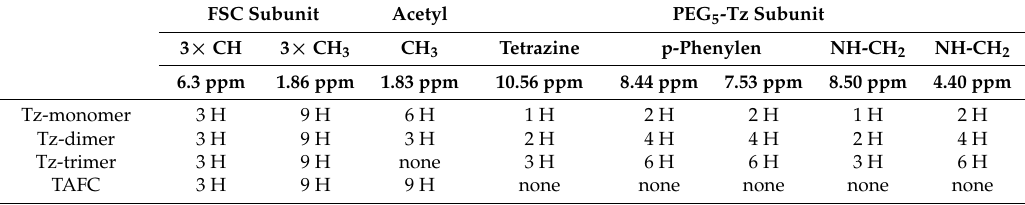
Table 1. 1 H-NMR data (chemical shifts and integrals) of characteristic signals of FSC-based Tz-conjugates and N , N ′ , N ′′ -triacetylfusarinine (TAFC) as a reference.